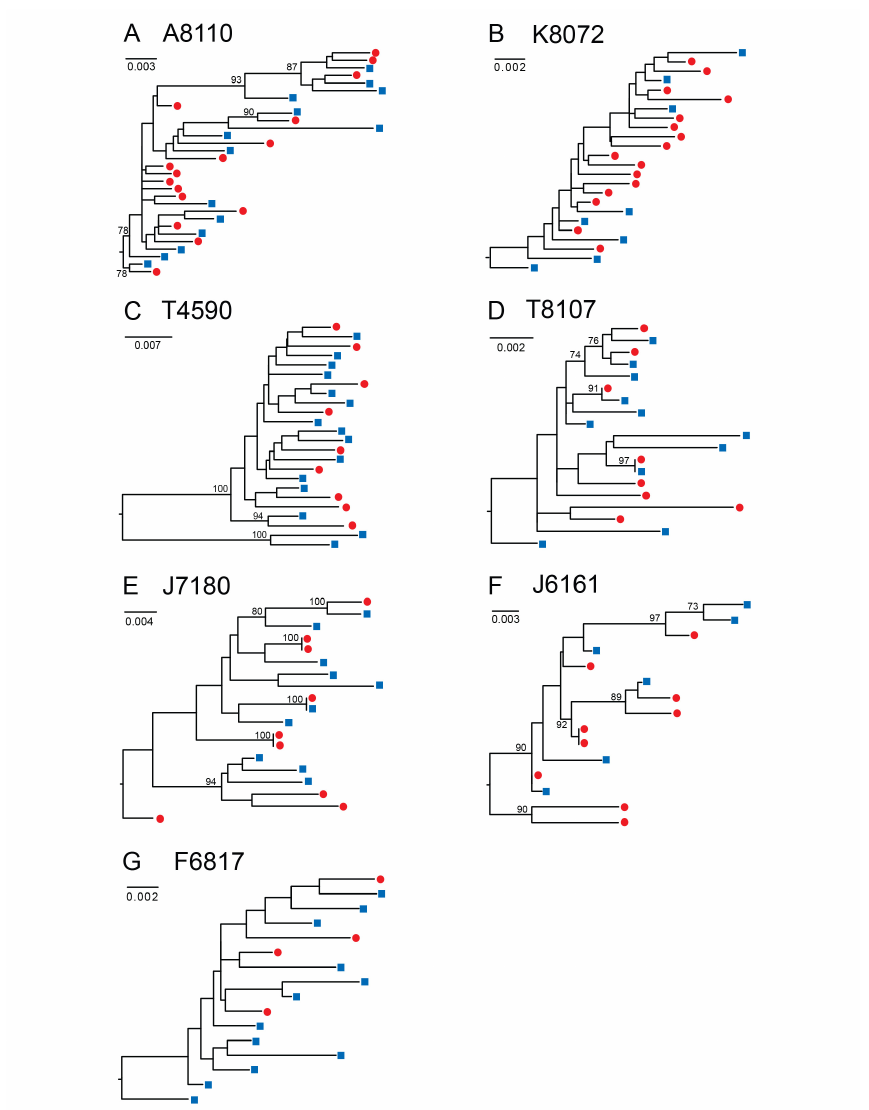
Figure 1. HIV-1 env sequences derived from DBS are genetically heterogeneous and phylogenetically indistinguishable from plasma variants . Maximum likelihood phylogenetic analyses are shown for gp160 HIV-1 env nucleotide sequences amplified by SGA from DBS (red circles) and plasma (blue squares) from seven chronically HIV-infected subjects (A to G). A single env sequence from subject T4590 (C) was excluded due to a large deletion. Numerals at nodes indicate approximate likelihood ratio test values of ≥ 0.73. The scale bar represents the number of nucleotide substitutions per